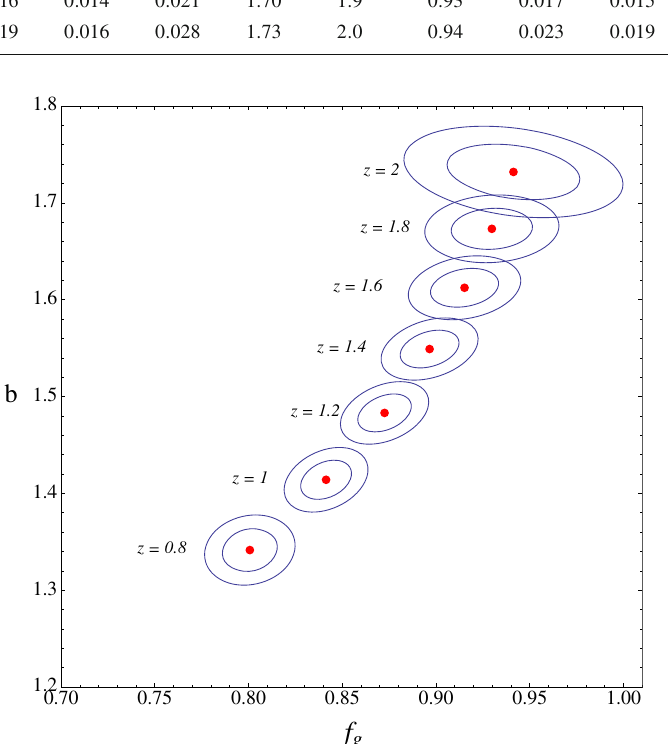
Fig. 17 Contour plots at 68 and 98% of probability for the pairs s ( z i ) − b ( z i ) in 7 redshift bins (with √ b = 1 + z ). The ellipses are centered on the fiducial values of the growth rate and bias parameters, computed in the central values of the bins, z